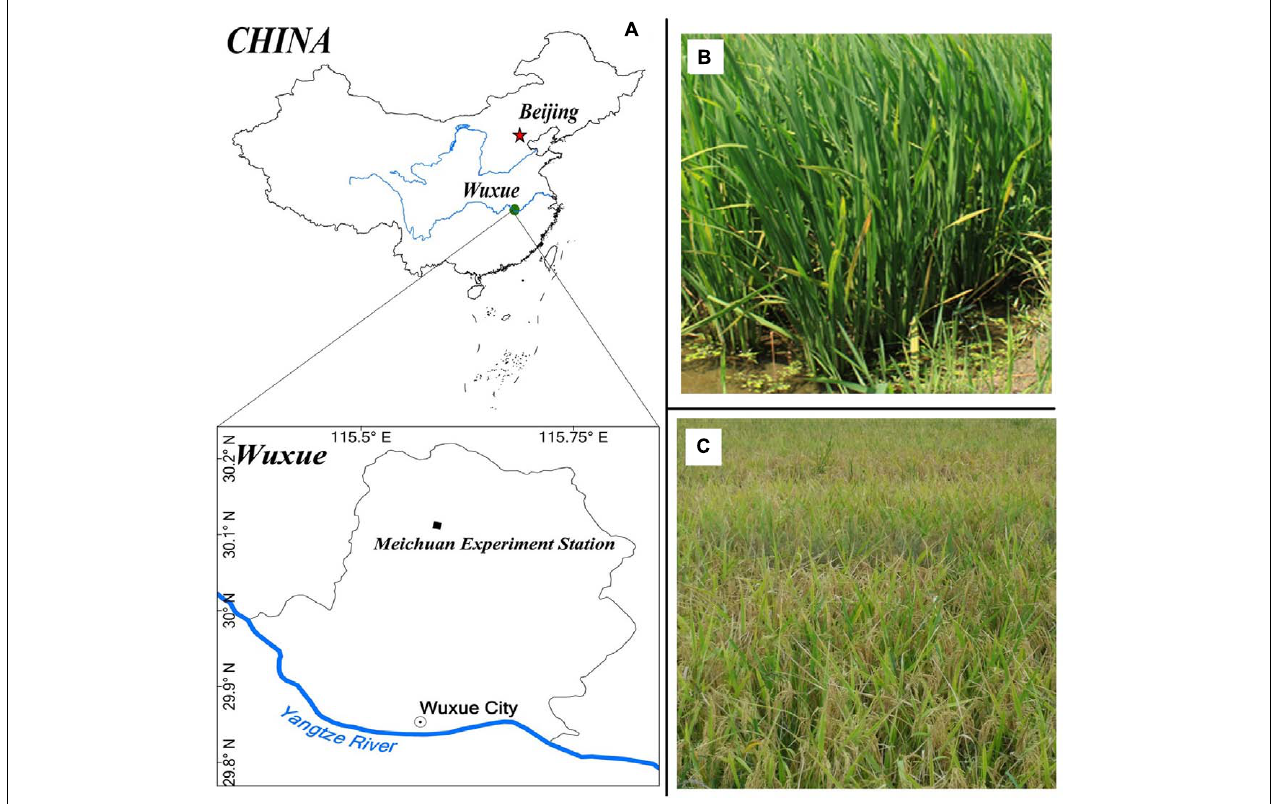
FIGURE 1 | Photographs of mid season rice in 2015 and 2016 (A) . Meichuan Experimental Station and field view (B) . Before heading (C) at